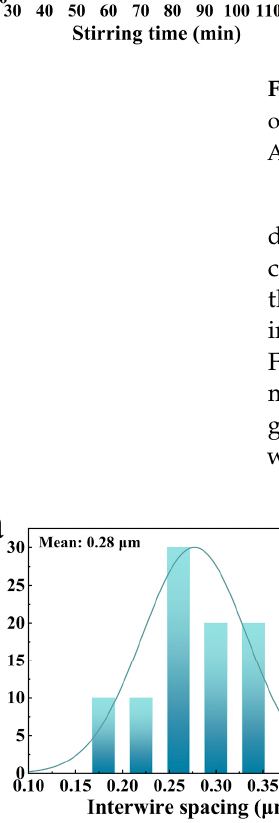
Figure 5. The interwire spacing distribution of 60 nm Ag NWs with stirring times of ( a ) 120 min, ( b ) 90 min, and ( c ) 30 min.